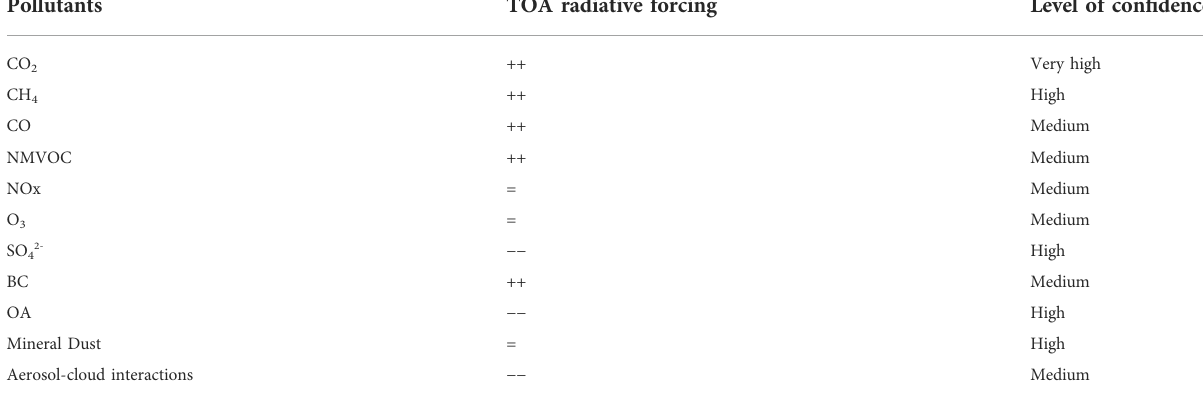
Symbols depict consistently positive (++), generally positive (+), weak or variable (=), generally negative ( − ), and consistently negative ( −− ), following Jacobs and Winner